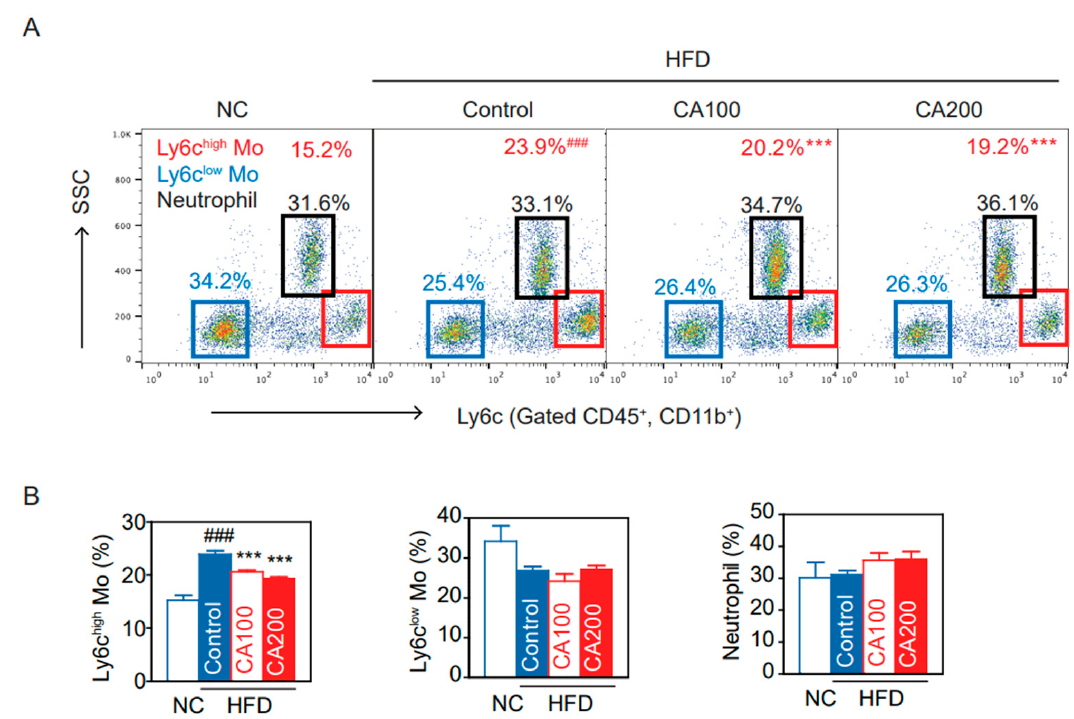
Figure 4. CA restored blood monocyte (Mo) subtypes in HFD mice: ( A ) flow cytometry of blood monocytes (Ly6c Mo) and neutrophils, and ( B ) percentage of Ly6c high monocytes, Ly6c low monocytes, and neutrophils. Data are expressed as the mean ± SEM ( n = 5). ### p < 0.001 vs. NC and *** p < 0.001 vs. HFD-control. NC, normal chow; Control, HFD-control; CA100, HFD plus CA 100 mg/kg; CA200, HFD plus CA 200 mg/kg.